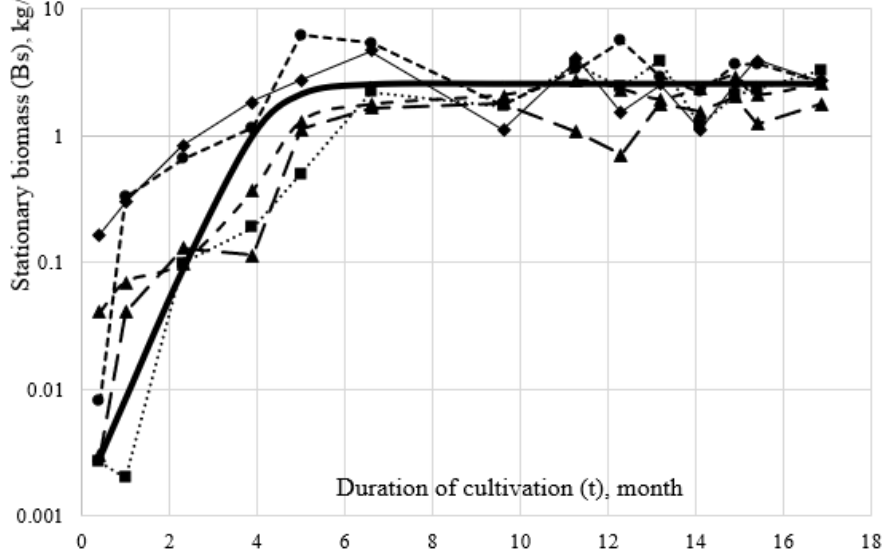
Figure 4. Relation between the stationary mussel biomass (B s ) and the duration of cultivation on the 1st type of collector (ω = 0.09); thickened line is an average value from 5 cultivation